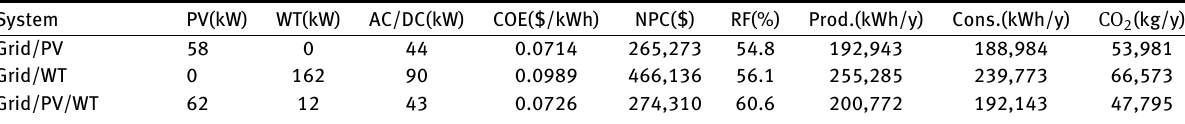
Table 7: Optimization results of grid-connected HRES systems for Tabuk University.